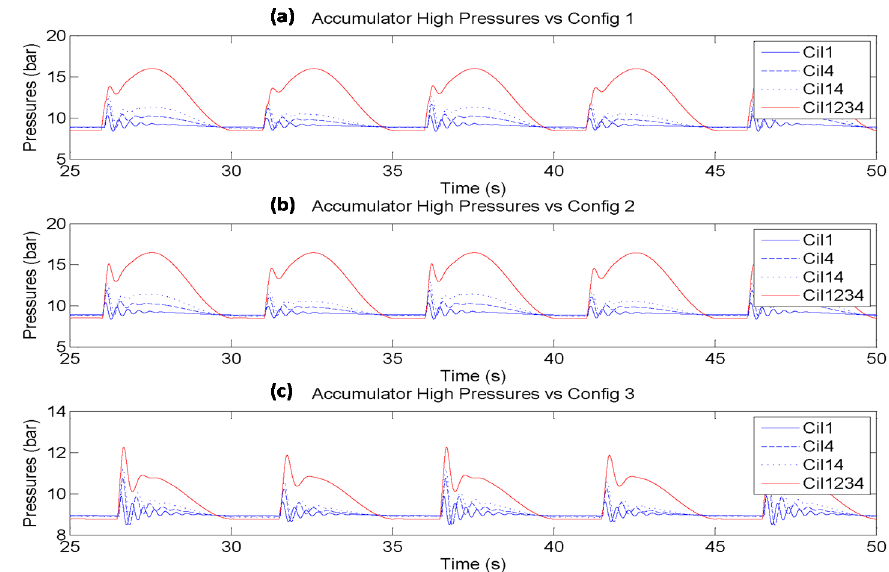
Figure 12. Instantaneous HP Accumulator pressure versus activated cylinders using different configurations: Config 1 ( a ), Config 2 ( b ) and Config 3 ( c